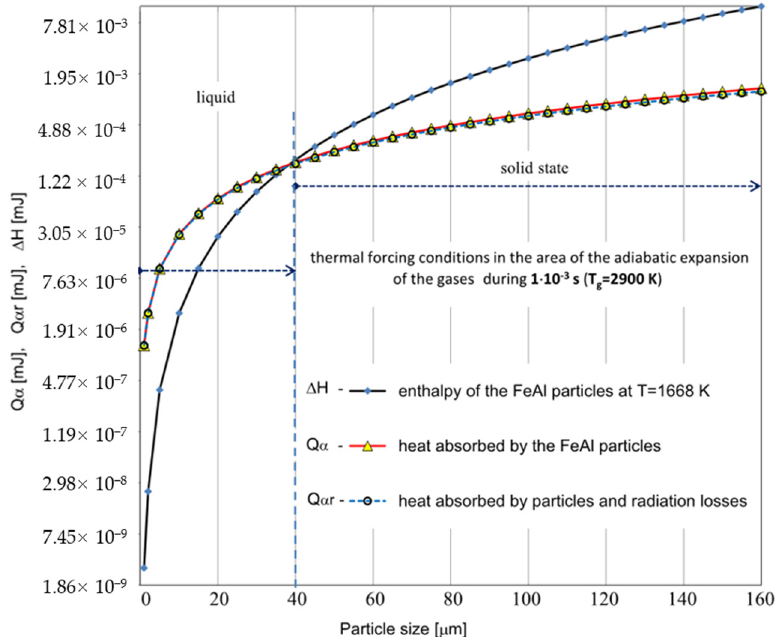
Figure 6. Comparison of the calculated values for the thermal energy Q α absorbed by the powder particles with the enthalpy of the FeAl alloy in the solid state at the melting temperature ∆ H, for different values of the particle diameter ranging from 1 µ m to 160 µ m. For the calculations, the parameters corresponding to the temperature of the gaseous medium of T = 2900 K during its inter- action time of τ A = 1 × 10 − 3 s were adopted (the dashed line represents the results of the Q α r calculations considering radiation losses).